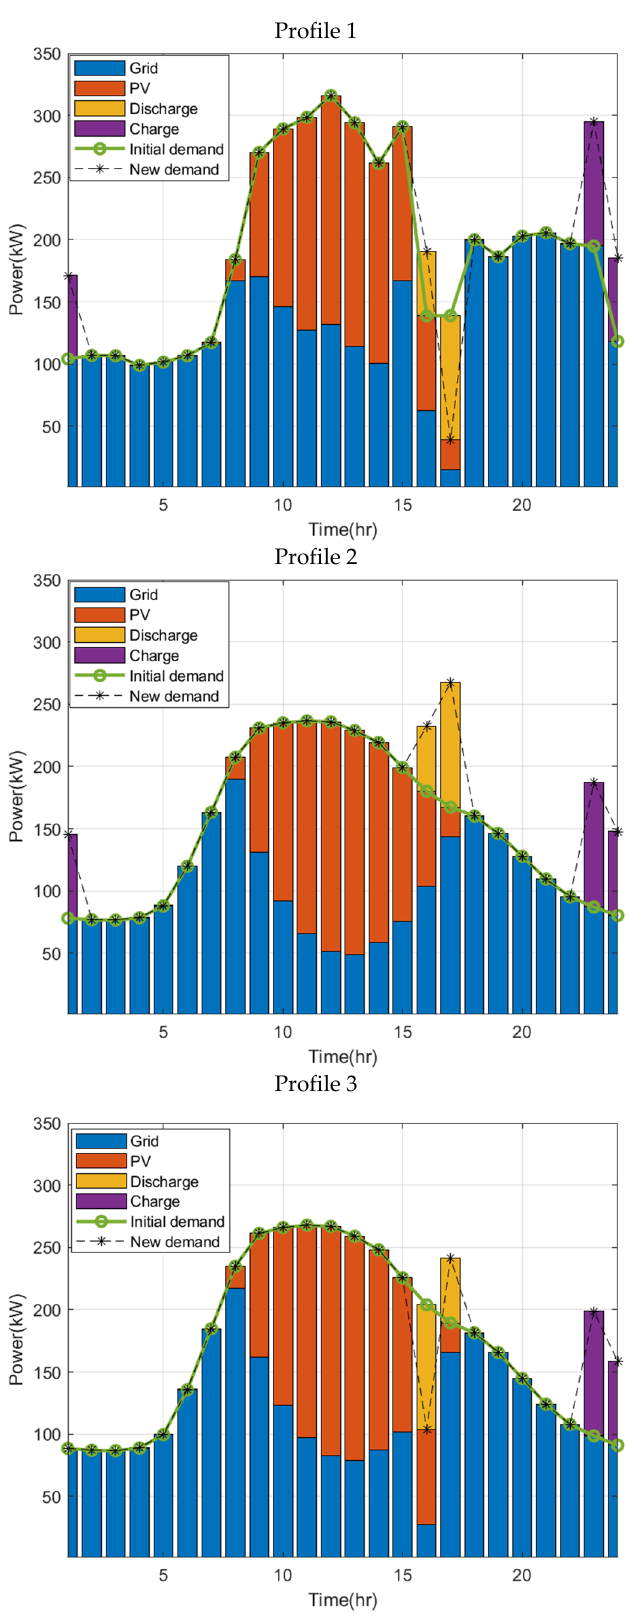
Figure 13. Operation of ESS in October. Profile 1—Using real smart meter data (Section 4.1.1); Profile 2—Using energy bills, standard profiles, and measurement for validation (Section 4.1.2); Profile 3—Using short-term measurement, standard profile, and contracted power (Section 4.1.3)